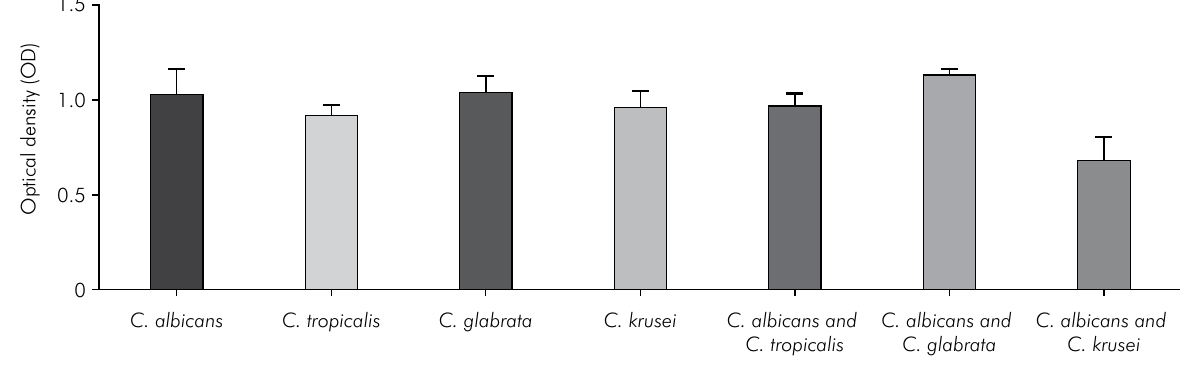
Figure 4. Mean values and standard deviation (n = 10) of the metabolic activity (XTT analysis) for single biofilms formed by C. albicans, C. tropicalis, C. glabrata or C. Krusei, and for mixed biofilms formed by the interactions of C. albicans - C. tropicalis , C. albicans - C. glabrata or C. albicans - C. krusei . Analysis of variance (ANOVA): statistically significant differences among the groups (p < 0.0001). Tukey test: C. albicans vs. C. tropicalis (p = 0.0982) , C. albicans vs. C. glabrata (p = 0.9999), C. albicans vs. C. krusei (p = 0.6625), C. tropicalis vs. C. glabrata (p = 0.0742), C. tropicalis vs. C. krusei (p = 0.9138), C. glabrata vs. C. krusei (p = 0.5859), C. albicans vs. C. albicans and C. tropicalis (p = 0.7269), C. albicans vs. C. albicans and C. glabrata (p = 0.2459), C. albicans vs. C. albicans and C. krusei (p < 0.0001), C. tropicalis vs. C. albicans and C. tropicalis (p = 0.8751), C. glabrata vs. C. albicans and C. glabrata (p = 0.3036), C. krusei vs. C. albicans and C. krusei (p <